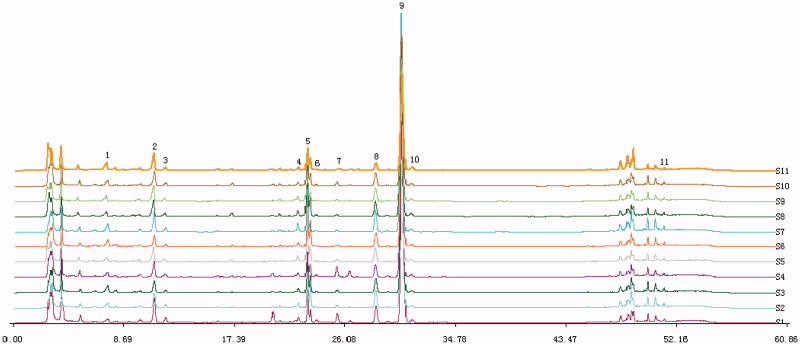
HPLC fingerprint graphics of AS. Analytical column: ODS-C18, 4.6 mm ×25 cm,5 μm; injected sample volume: 10 μL; mobile phase: 1.0% acetic acid in water (A) and acetonitrile (B) using a gradient program of 20–30% (B) in 0–10 min, 30–49% (B) in 1 0–20 min, 49% (B) in 2 0–40 min; 49–100% (B) in 40–50 min;100–20% (B) in 5 0–60 min; flow rate: 1 mL·min- 1; temperature: 25 °C; UV detection: 280 nm. (1) ferulic acid; (2) senkyunolide I; (3) senkyunolide H; (4) unkown compounds; (5) coniferyl ferulate; (6) senkyunolide A; (7) butylphthalide; (8) E-ligustilide; (9) Z-ligustilide; (10) Z-butylidenephthalide; (11) levistolide A.